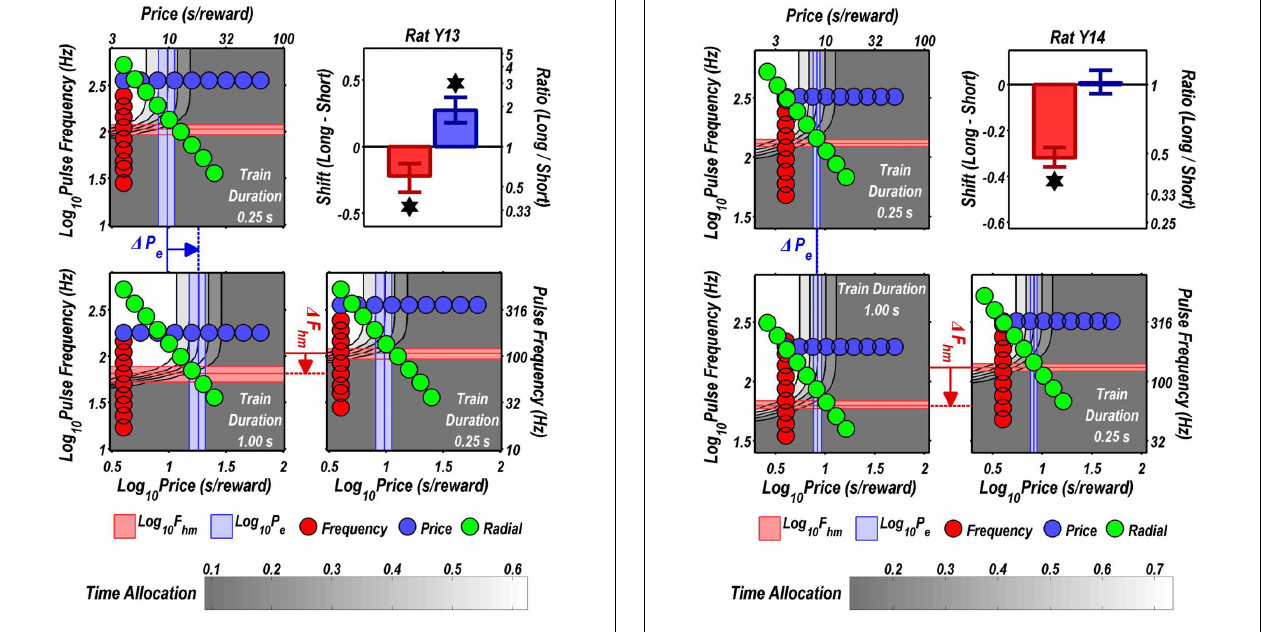
FIGURE 6 | Shifts of the reward mountain. The contour graph for the long-duration (1s) train is shown in the lower left. For comparison the contour graph for the short-duration (0.25s) train is shown twice, in the upper left and lower right. The P e parameter determines the location along the price axis, whereas the F hm parameter determines the location of the mountain along the pulse-frequency axis. The vertical blue line represents the estimate of P e , and the surrounding band represents the corresponding 95% confidence interval. The horizontal red line represents the estimate of F hm , and the surrounding band represents the corresponding 95% confidence interval. The bar graph shows the mean shifts in the location parameters due to the increase in train duration from 0.25 to 1s along with the associated 95% confidence intervals. ∗ Indicates that the 95% confidence interval does not include zero.